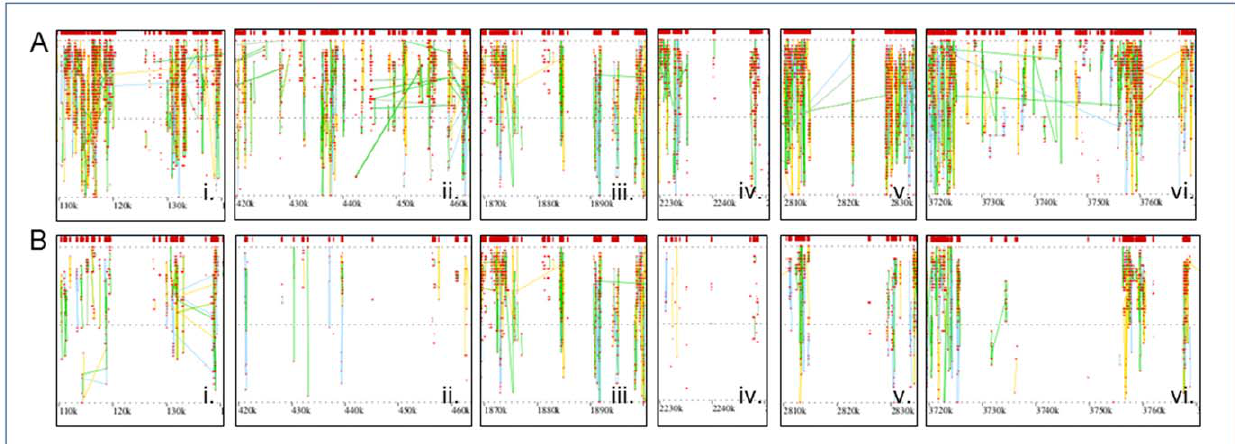
Figure 2. Metagenomic islands (MIs) of bloom-associated Microcystis . Metagenomic islands (MIs) identified in the Lake Erie and Taihu Microcystis recruitments. Six regions in Taihu and three in Erie qualified as MIs. MIs were defined as regions of $ 10 kb in length that have an average similarity of less than 25% to the reference genome and less than 25% total coverage of the corresponding base pairs of the reference sequence. A) View of MIs of Lake Erie Microcystis recruitment. Boxes ii, iii, and vi were found to be MIs in Taihu, but did not satisfy our criteria in Lake Erie. E) View of MI regions in Taihu Microcystis recruitment.